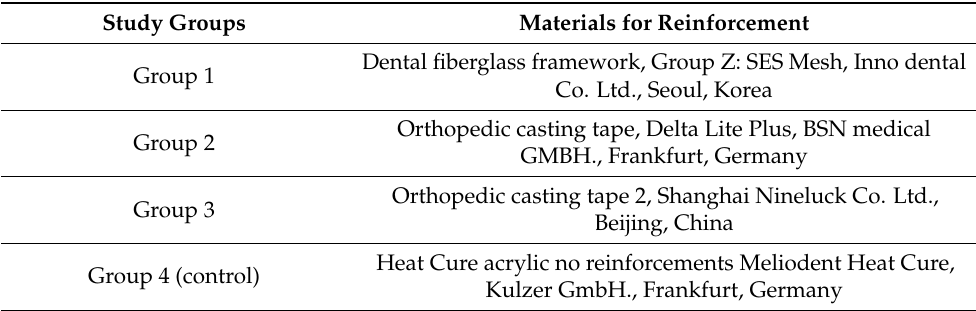
Table 1. Materials used for acrylic reinforcement in study